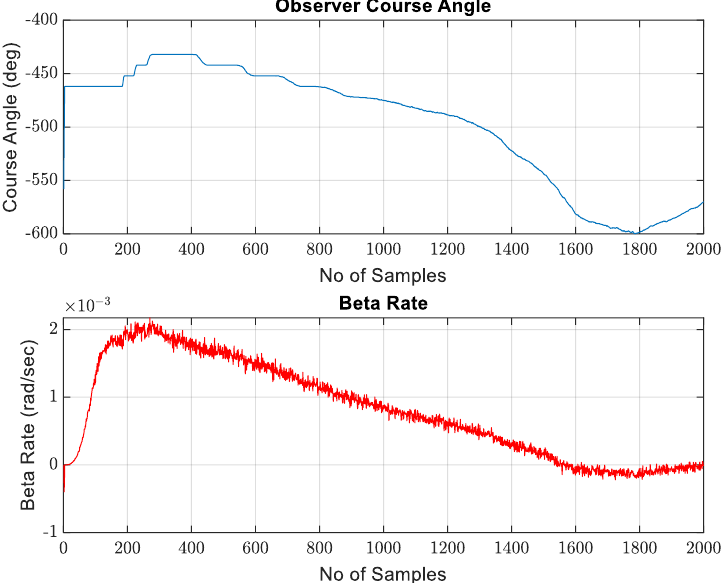
coordinates. The initial range error reduces to a minimum of 192 m and 287 m due to the observer at position coordinates (1000, 0) and (0, − 3000), respectively. The results show that all estimated target trajectories plotted on the same graph ultimately converge to the actual uniform target trajectory at the final sampling time.